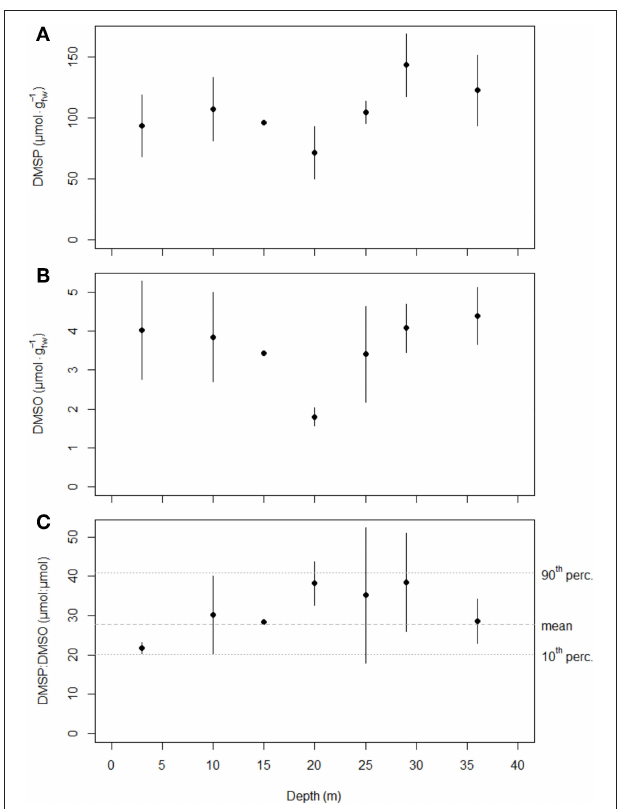
FIGURE 4 | Evolution of (A) the DMSP concentration ( µ mol.g − 1 fw ), (B) the DMSO concentration ( µ mol.g − 1 fw ) and (C) and the DMSP:DMSO ratio ( µ mol: µ mol) in P. oceanica third leaf along the 3–36m depth transect (mean ± sd, n = 3 except at depths 15m, n = 2 and 10m, n = 12). Tenth and ninetieth percentiles (horizontal dotted gray lines) and the mean ratio value (horizontal dashed gray line) of the interpercentile range for the 10m depth survey are reported on the DMSP:DMSO ratio graph (C)